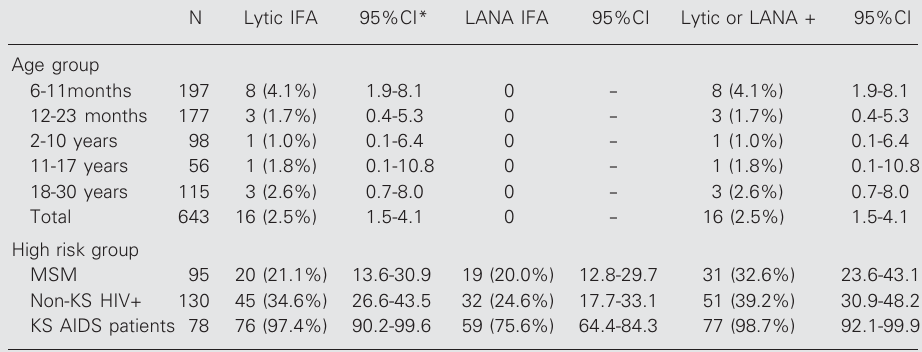
Table 1. Prevalence of HHV-8 antibodies in children and adults from the general population of São Paulo State and in high risk groups for HHV-8